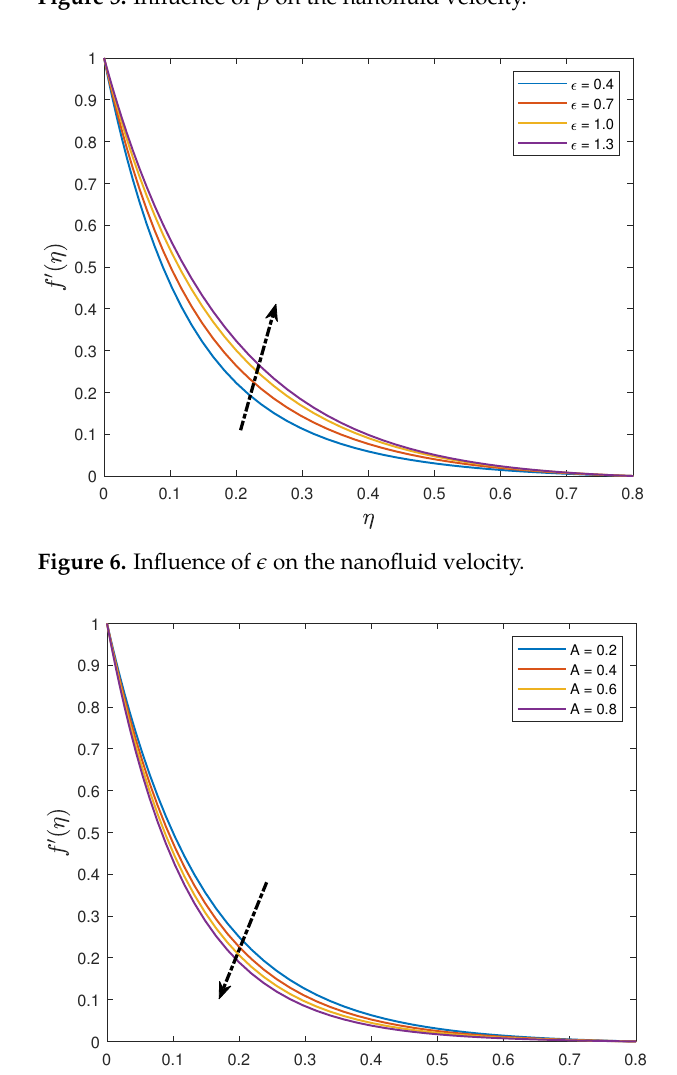
Figure 5. Influence of β on the nanofluid velocity.